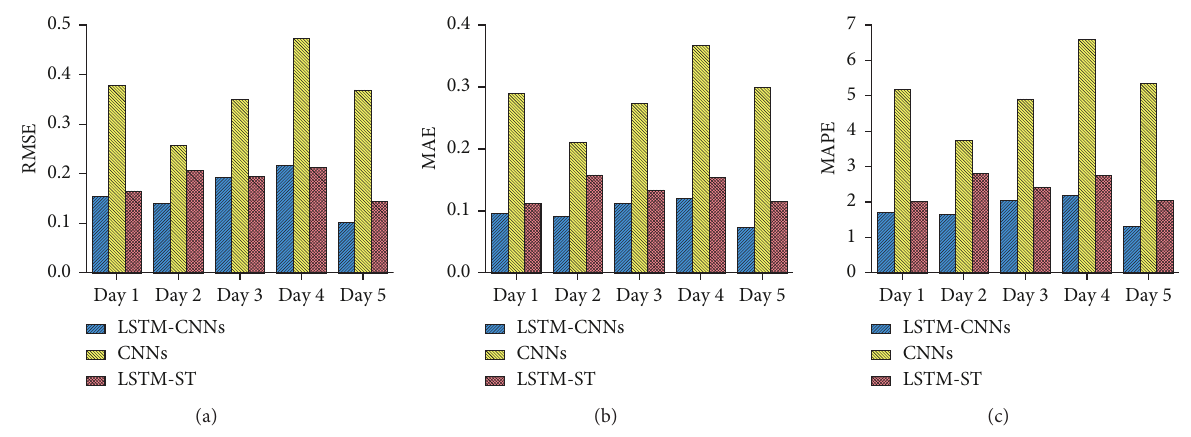
Figure 11: Comparison of results for LSTM-CNN, CNN, and LSTM-ST. Table 6: Error results of LSTM-CNN, CNN, and LSTM-ST for 5 days.